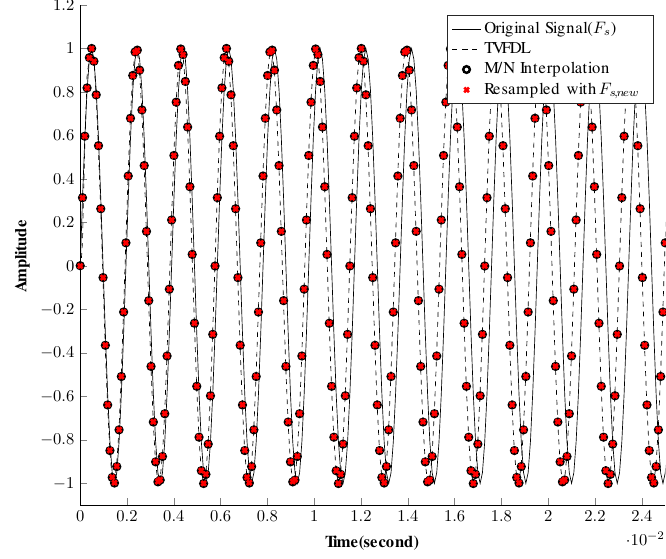
Figure 3. Comparison between different resampling methods applied to a 512-Hz sine wave with a sampling frequency of F s = 10,240 Hz.